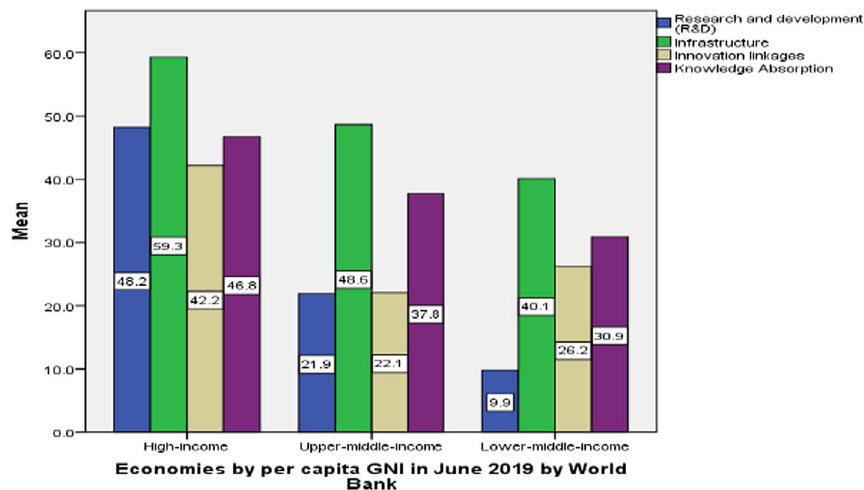
Fig. 2 Innovation activities as per countries’ income level (Source: Own study result,